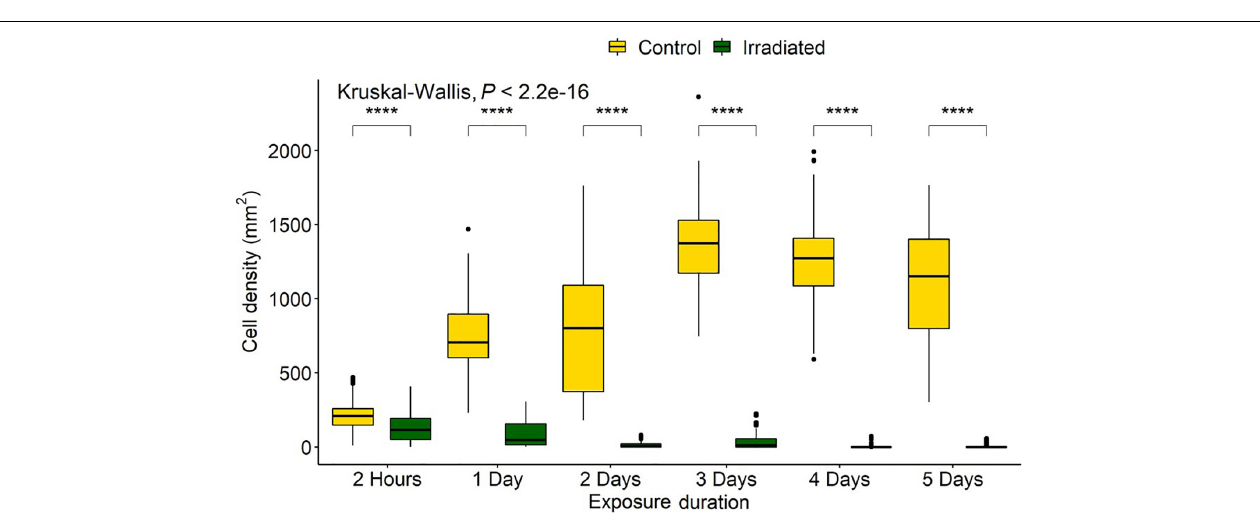
FIGURE 4 | Navicula incerta densities after UV irradiance over varying periods. Durations of 2 h, 1, 2, 3, 4, and 5 days produced fluences of 0.78, 9.35, 18.70, 28.05, 37.40, and 46.75 J/cm 2 , respectively. Kruskal-Wallis value displayed with Wilcoxon pairwise comparison arranged above groupings (**** P <